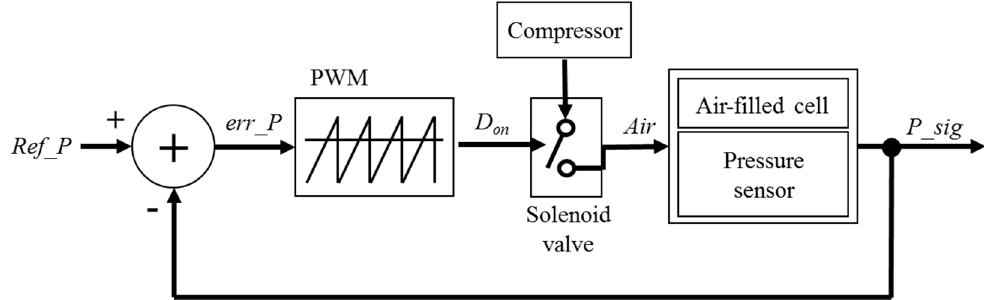
Figure 2. The block diagram of the closed-loop control mechanism in the system.